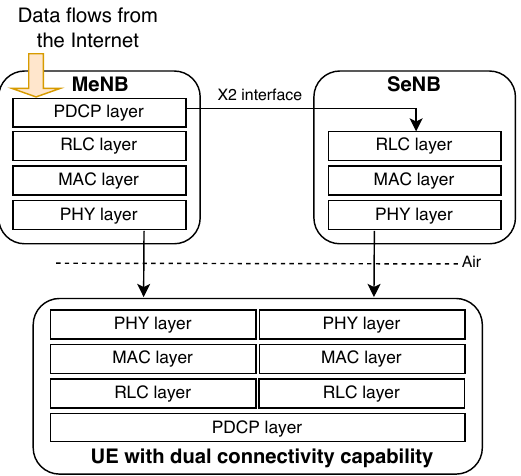
Figure 1. The protocol stack of a cellular network with dual connectivity